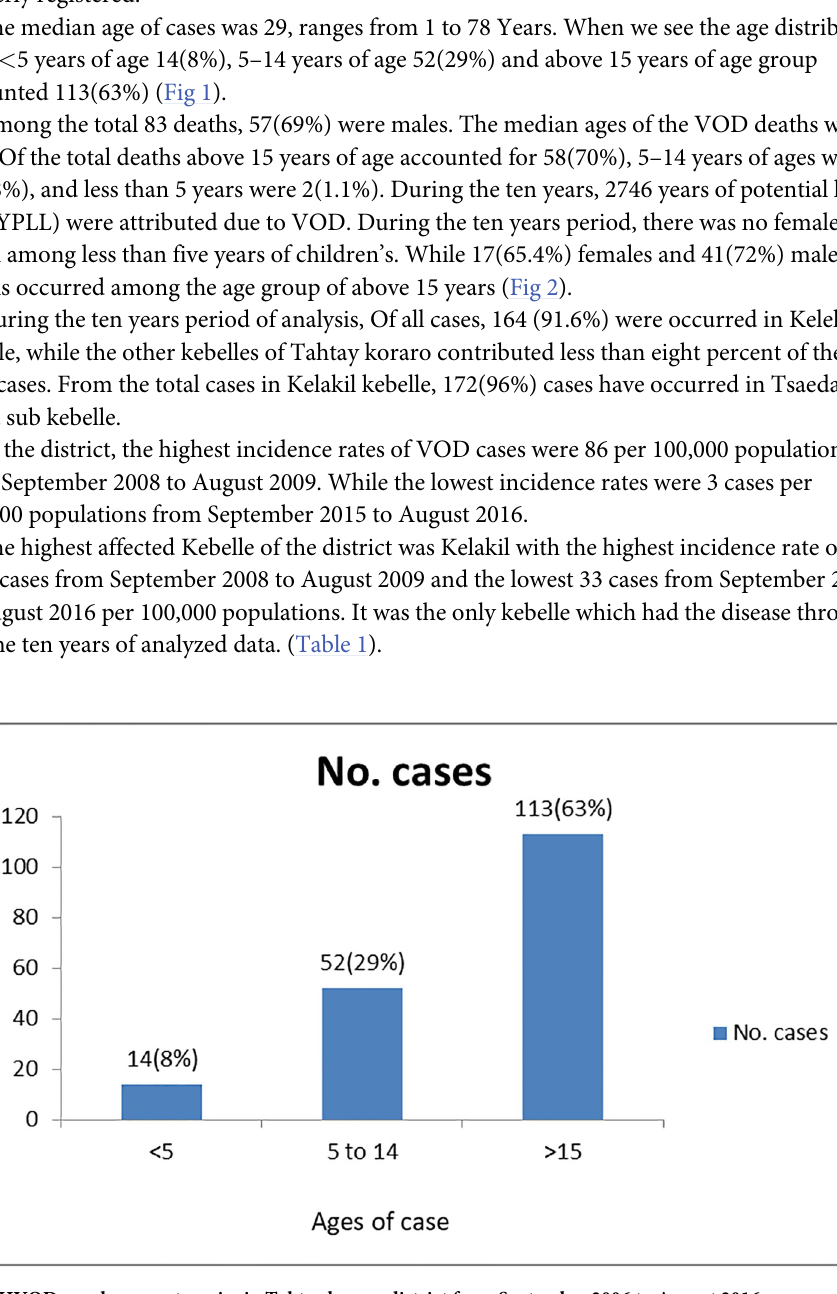
PLOS ONE | https://doi.org/10.1371/journal.pone.0224659 November5,